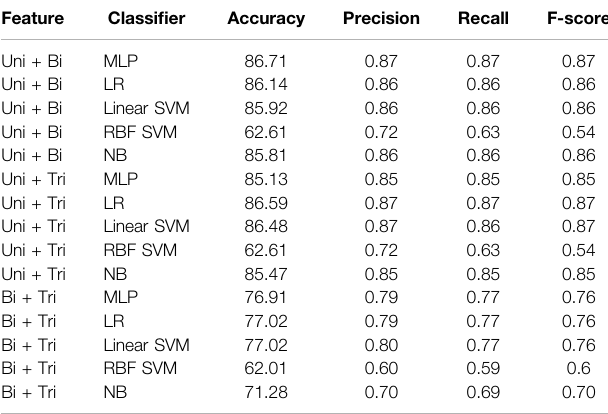
TABLE 4 | Comparison of combination of N-gram